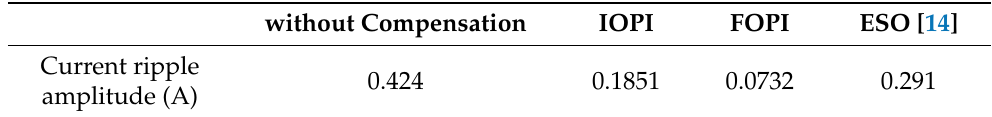
Figure 26. Comparison of I d current response. Table 10. The performance index comparison of I d step current